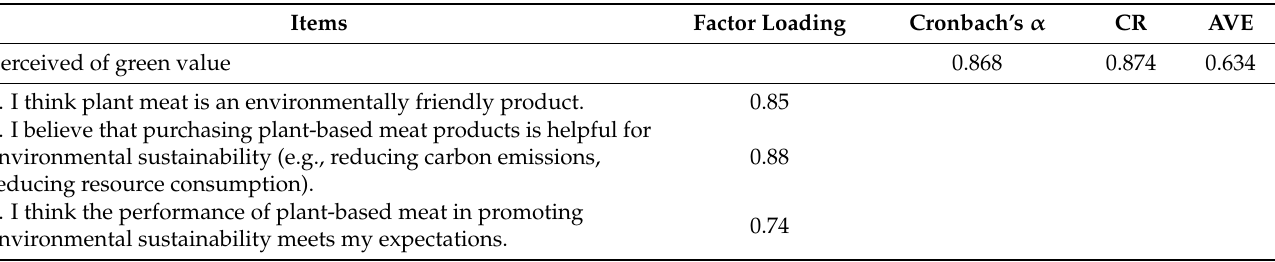
Table 3. Results of factor loading, reliability, and